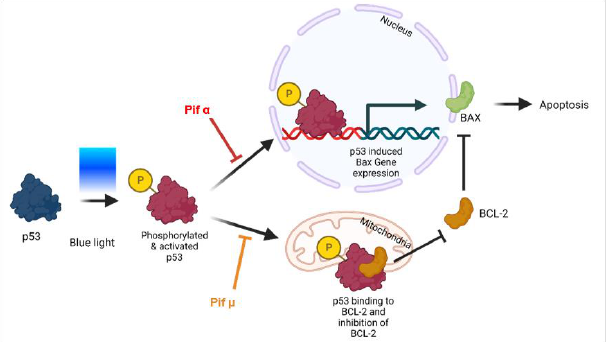
Figure 5. Blue light-induced apoptosis can be prevented through p53 inhibition (model). Although direct effects have not yet been shown, it is likely that following blue light (BL) exposure, the tumor suppressor protein p53 is modified (e.g., phosphorylated) and, thus, accumulates in an activated form in the cell, resulting in expression of its pro-apoptotic target genes such as Bax . Based on current knowledge, pifithrin α (Pif α), a cell-permeable transcriptional p53 inhibitor, inhibits p53-dependent gene transcription. Therefore, Pif α could prevent Bax expression after BL exposure. It is further known that pifithrin µ (Pif µ) prevents p53 function on the mitochondrial side without affecting p53 transcriptional activities. Activated and accumulated p53 normally binds to BAX inhibitor BCL-2, thus resulting in an increase in free BAX and induced apoptosis. Therefore, Pif µ treatment could block the binding of p53 to BCL-2, resulting in an increase in free BCL-2 and, therefore, less free pro-apoptotic BAX. Pif µ could, therefore, also inhibit BL-induced apoptosis.